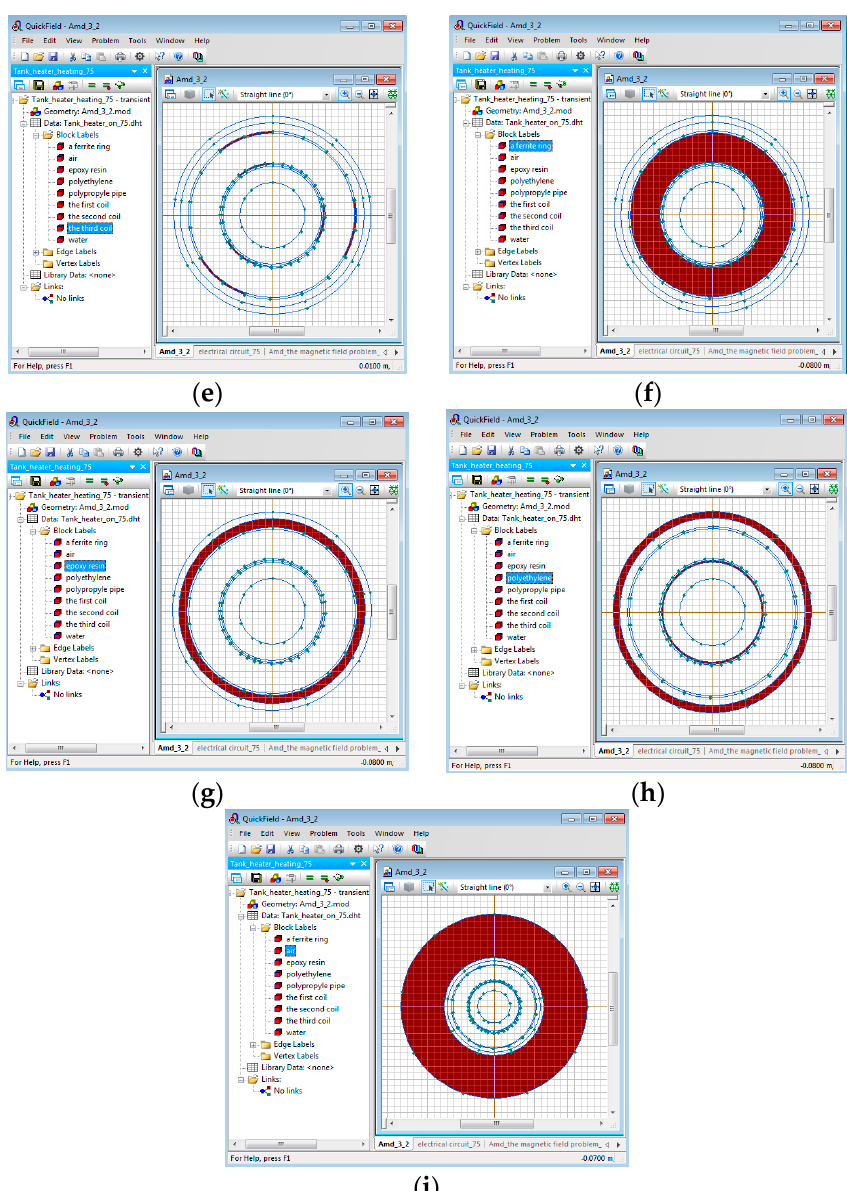
Figure 6. The geometric representation of the labels: ( a ) label “water” and geometrical representation, ( b ) label “a polypropylene pipe” and geometrical representation, ( c ) label “the first coil” and geometrical representation, ( d ) label “the second coil” and geometrical representation, ( e ) the marking “the third coil” and geometric representation, ( f ) the marking “a ferrite ring” and geometric representation, ( g ) the marking “epoxy resin” and geometric representation, ( h ) the marking “polyethylene” and geometric representation, ( i ) the marking “air” and geometric representation.